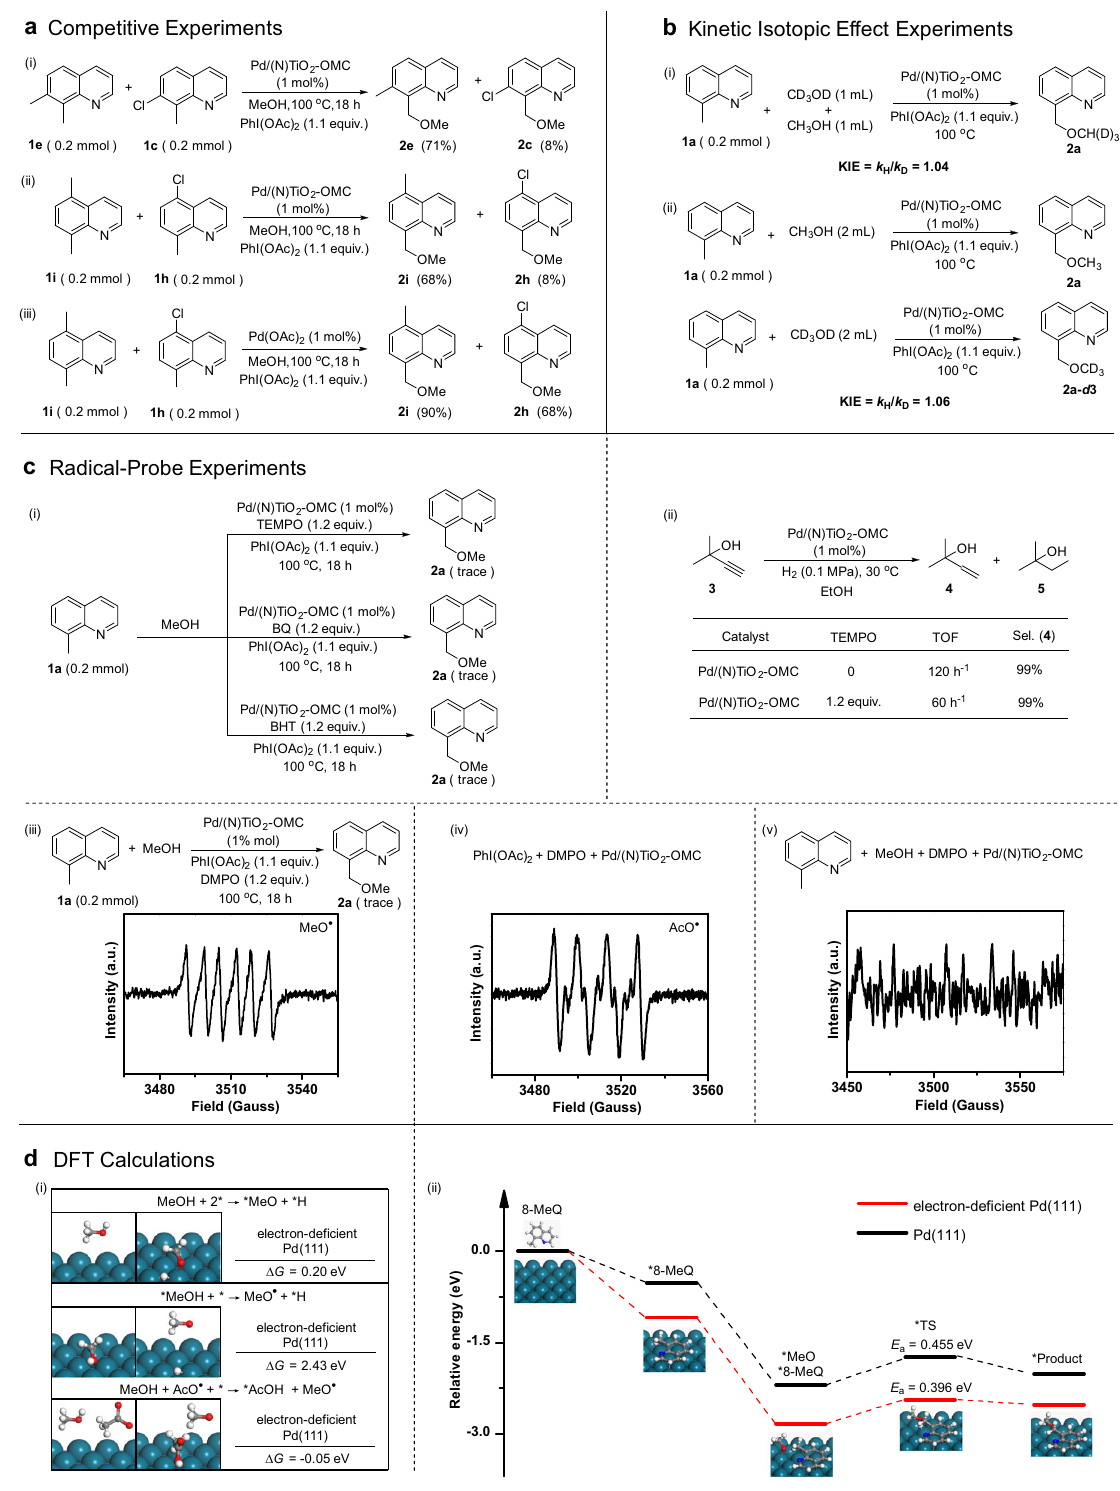
Fig. 4 Reaction mechanism. a Intermolecular competition experiments between substituted quinolines showing the effects of electron-withdrawing or donating substituents on the Pd catalyzed direct methoxylation of quinolines. b Kinetic isotope effects measured using deuterated substrates under (i) intermolecular competition and (ii) independent experiments. c Radical trapping experiments and EPR spectra. (i) TEMPO, BQ and BHT were used as radical scavengers to quench the reaction. (ii) Excluding the complete poisoning effect of the radical scavenger of TEMPO on the Pd nanocatalyst in a reaction which is apparently not a radical-involving reaction (hydrogenation of 2-methyl-3-butyn-2-ol). (iii – v) EPR spectra of radical anions when the radical spin trapping reagent DMPO was added to (iii) the reaction system, (iv) in the absence of methanol, and (v) in the absence of PhI(OAc) 2 . d DFT calculations. (i) Generation of methoxyl radicals by Pd-catalyzed radical relay reaction over an electron-de fi cient Pd(111) surface. (ii) Reaction paths and energy landscape of the direct methoxylation of 8-MeQ over Pd(111) and an electron-de fi cient Pd(111) surface.